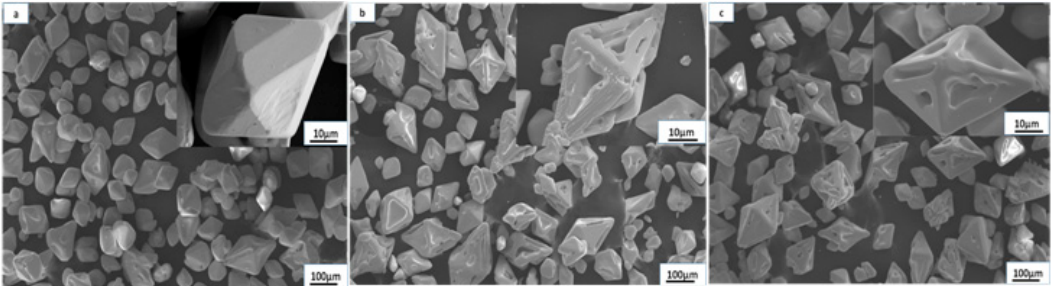
Figure 3. SEM images of the NH 4 ReO 4 particles with different stirring paddle types ( a —disc turbine impeller; b —propelling propeller; and c —Intermig impeller).